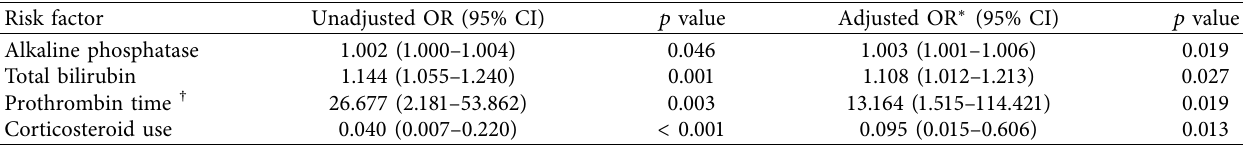
Table 5: Risk factors for adverse outcomes in acute autoimmune hepatitis patients.